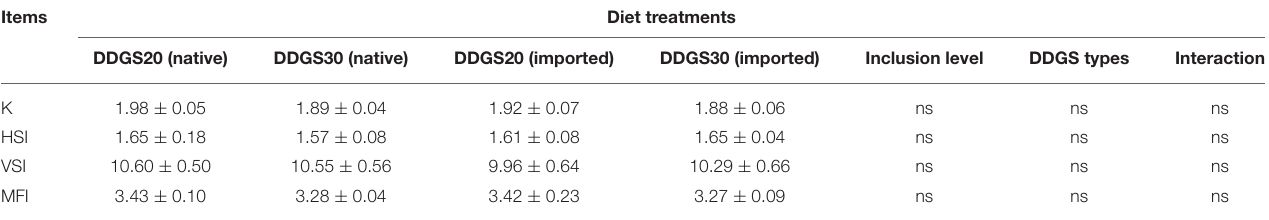
TABLE 4 | The effects of different types and levels of dietary DDGS on the body index of juvenile grass carp a . Items